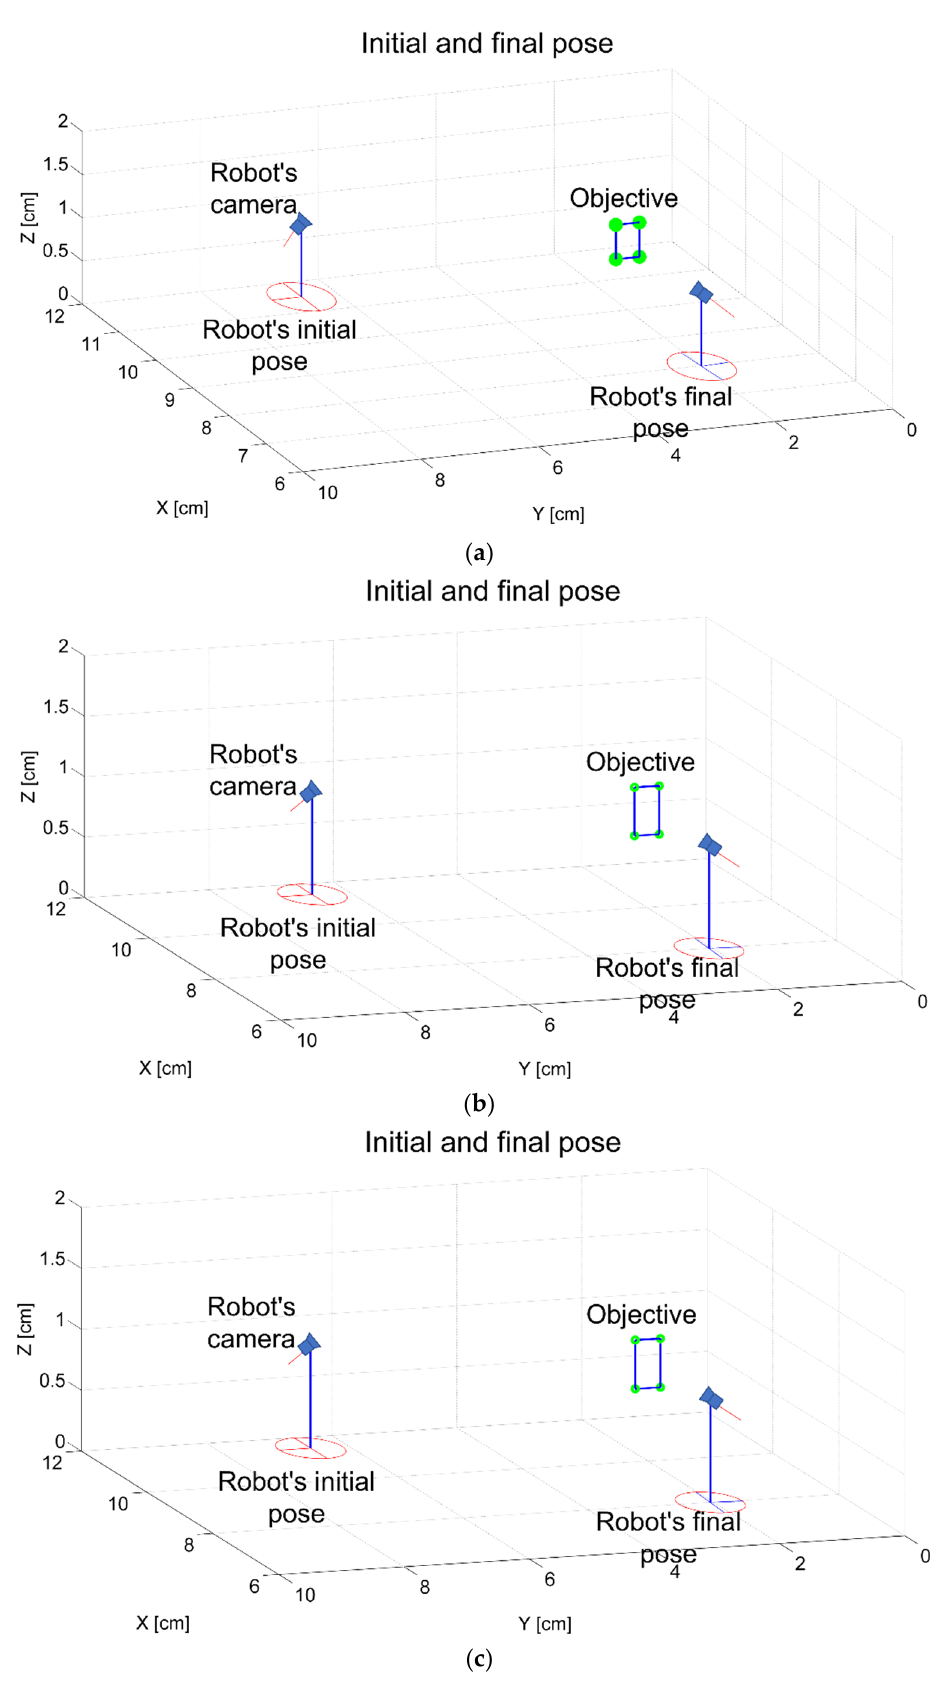
Figure 10. Initial and final poses after applying ( a ) IBVS, ( b ) PBVS, and ( c ) HBVS control.